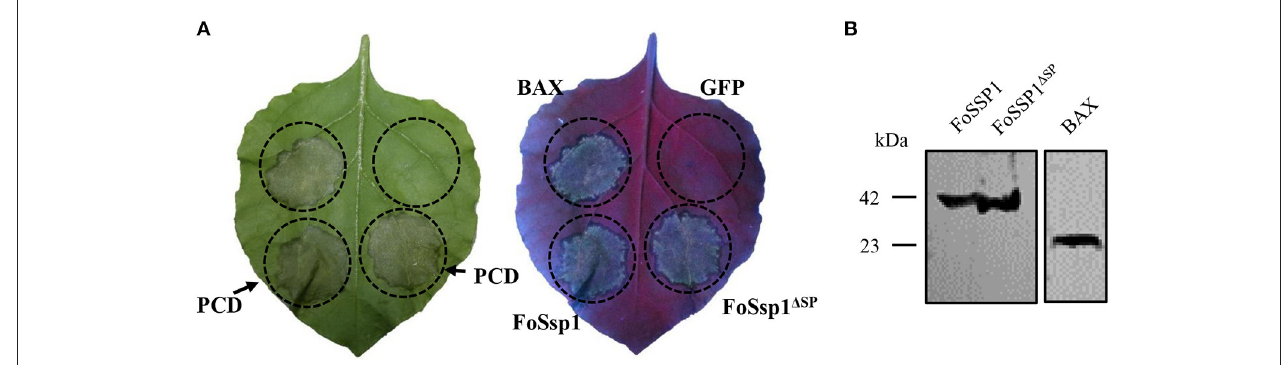
FIGURE 3 | FoSsp1 was transiently expressed in the N. benthamiana by A. tumefaciens -mediated transformation. (A) FoSsp1 induced cell death in tobacco leaves. The recombinant vectors of pBin- FoSSP1 and pBin- FoSSP1 1 SP were infiltrated into leaves by A. tumefaciens -mediated transformation. Empty vector pBin-eGFP (EV) was used as negative control and Bax as positive control. After 5 days of infiltration, the hypersensitive response was indicated by ultraviolet (UV) light. The experiment was repeated at least four times. (B) Western blot analysis was used to detect the protein